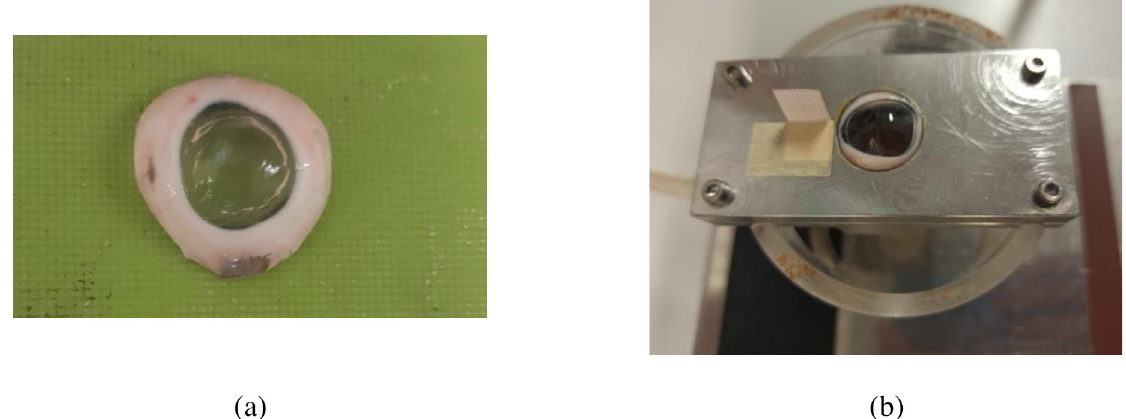
Fig 1. (a) Cornea specimen de-epithelized, incised, and cleaned for the inflation tests. (b) Grip system used for clamping the cornea Fig 1B. The spherical cap surface was slightly roughened to facilitate the positioning of the samples and it was surrounded by an O-ring to avoid leakage. The two plates were assembled with four tightening screws, located in proximity of the vertices, to exclude the onset of stress concentrations or unnatural pre-tensioning.